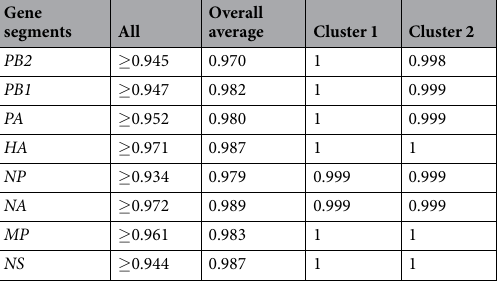
Table 2. The nucleotide identity of complete gene segments from selected representative H7N9 virus including the two family